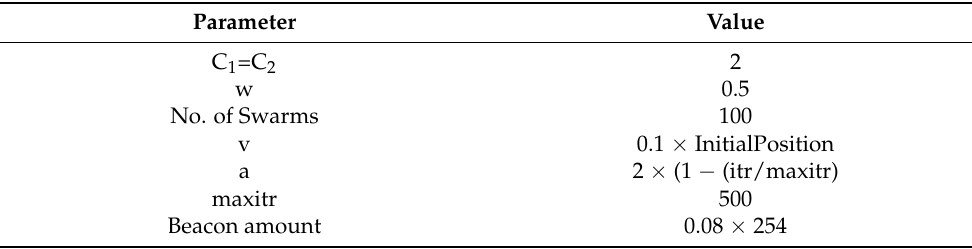
Table 7. Parameters used by node localization algorithm.